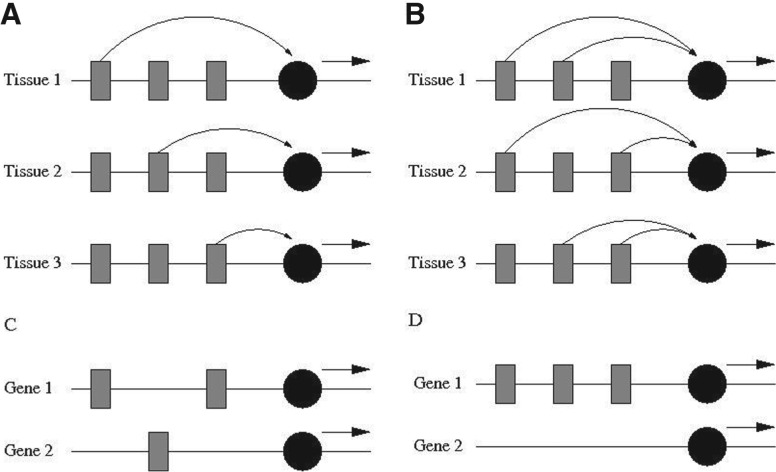
Alternative models of UCNE action and corresponding retention patterns after whole-genome duplication. Grey rectangles represent UCNEs (supposed to be remote control elements), the black circles represent the promoter of the target gene (not supposed to be ultraconserved). (A) Stand-alone model: each UCNE drives independently of the other UCNEs the expression of the target gene in one particular tissue. (B) Cooperative model: the simultaneous activity of at least two UCNEs is required for target gene expression. Different combinations of UCNEs drive expression in different tissues. (C) Reciprocal retention pattern after WGD expected under the stand-alone model: UCNEs get randomly distributed over the two daughter genes. (D) ‘Winner-takes-all’ retention pattern expected under the cooperative model. UCNEs need to be retained by the same daughter gene in order to ensure expression in all tissues